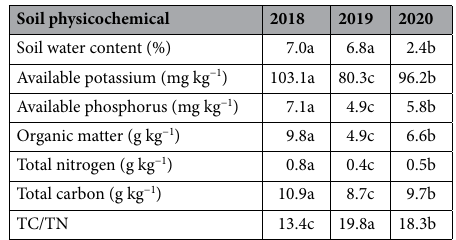
Table 1. The physical chemical properties at 0–20 cm depth at the experimental field. Numbers followed by different letters in each row indicate significantly differences at α = 0.05 based on ANOVA